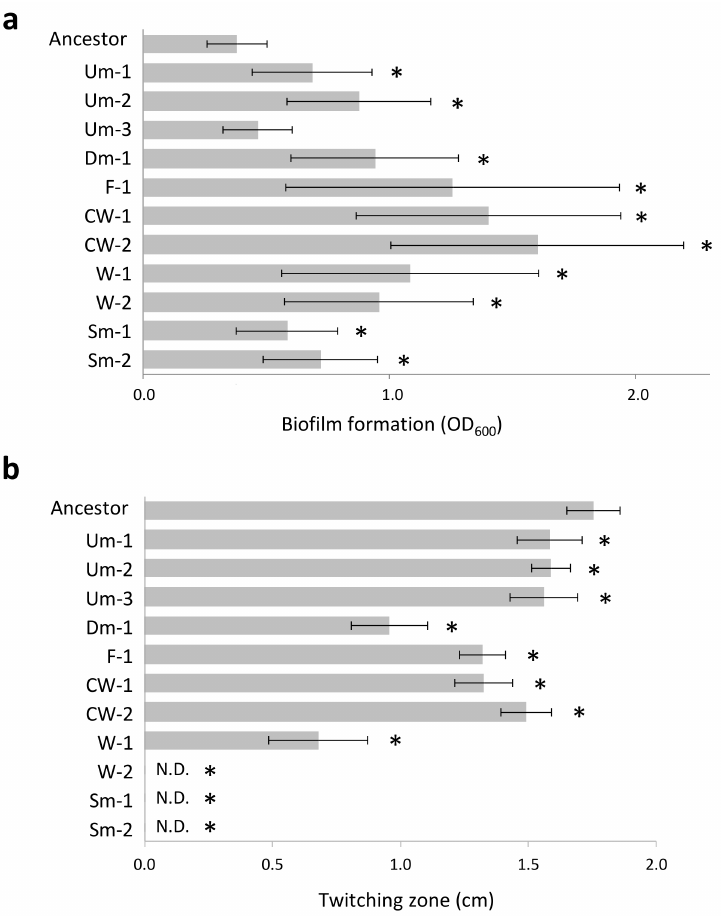
Figure 2. Phenotypic features of CMVs. ( a ) Biofilm formation (24 h). Values are expressed as means for three independent experiments ( n = 6). Error bars indicate SD. Asterisks indicate statistically significant difference to Ancestor (student’s t -test, p < 0.01). ( b ) Twitching motility (48 h). Values are expressed as means for three independent experiments ( n = 3–5). Error bars indicate SD. Asterisks indicate statistically significant difference to Ancestor (student’s t -test, p < 0.01). N.D., Not